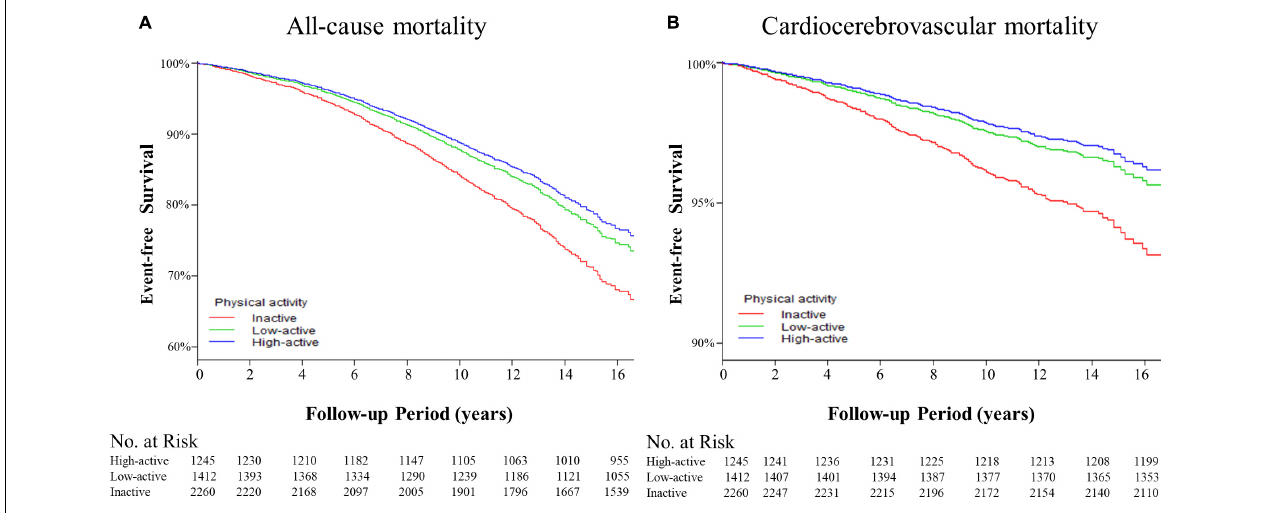
FIGURE 2 | The Kaplan-Meier curves for event-free survival of the adverse outcomes among patients with hypertension. (A) The event-free survival rate for the all-cause mortality. High-active group vs. low-active group, p = 0.611; high-active group vs. inactive group, p < 0.001; low-active group vs. inactive group, p < 0.001 by log-rank tests. (B) Event-free survival rate for cardiocerebrovascular mortality. High-active group vs. low-active group, p = 0.975; high-active group vs. inactive group, p < 0.001; low-active group vs. inactive group, p < 0.001 by log-rank tests.